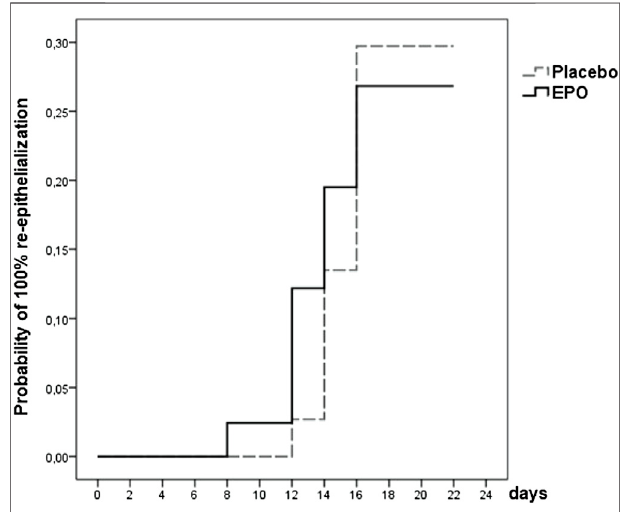
FIGURE 3 | Survival function showing the likelihood of 100% re- epithelialization through day 21 for patients from both treatment arms whose study wound healing process was fully documented (data were censored for 56 (72%) patients).